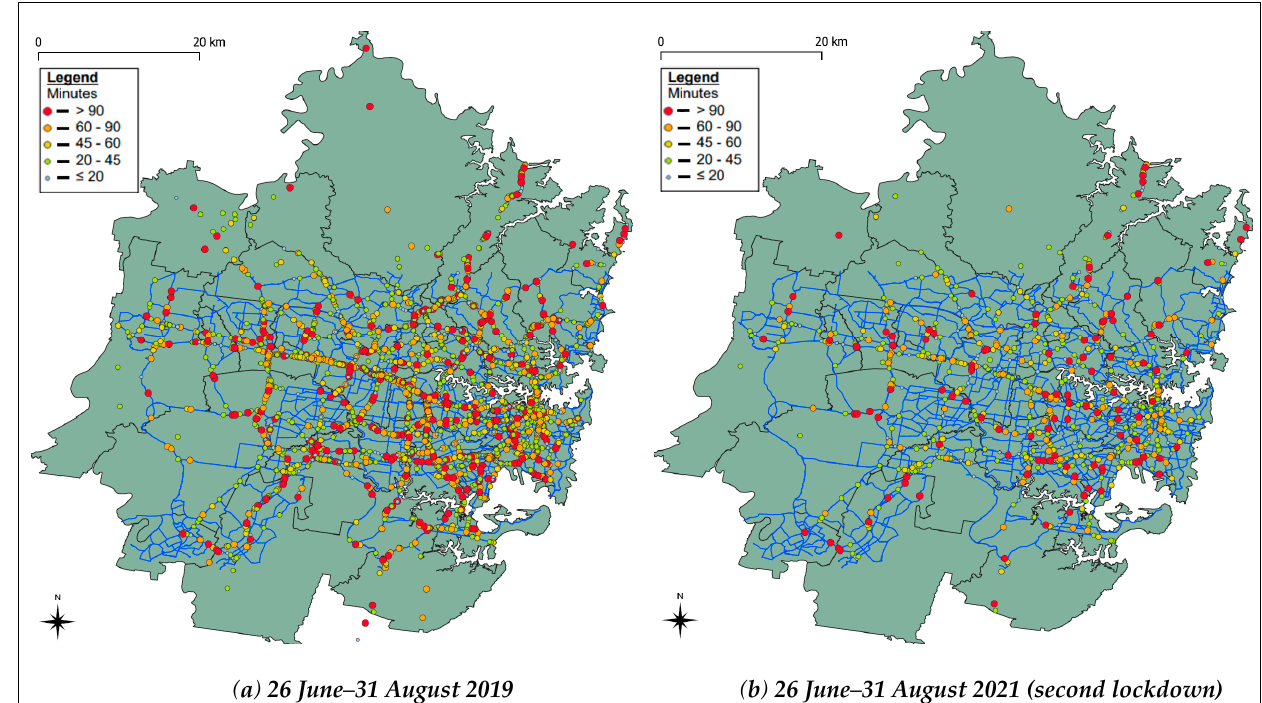
Figure 3. The comparison of incidents (breakdowns and crashes) in Sydney, colour-coded by duration. ( a ) During the period 26 June–31 August 2019 and ( b ) 26 June–31 August 2021 (second lockdown).